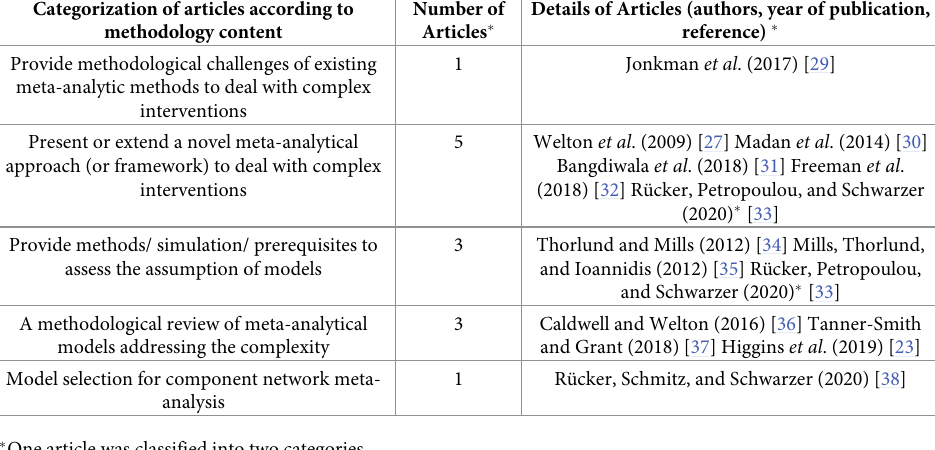
Table 1. Categorization of the twelve methodological articles with meta-analysis models that evaluate the effects of complex interventions. Categorization of articles according to Number of methodology content Articles � Provide methodological challenges of existing meta-analytic methods to deal with complex interventions Present or extend a novel meta-analytical approach (or framework) to deal with complex interventions Provide methods/ simulation/ prerequisites to Thorlund and Mills (2012) [34] Mills, Thorlund, assess the assumption of models and Ioannidis (2012) [35] Ru¨cker, Petropoulou, A methodological review of meta-analytical Caldwell and Welton (2016) [36] Tanner-Smith models addressing the complexity and Grant (2018) [37] Higgins et al . (2019) [23] Model selection for component network meta- 1 Ru¨cker, Schmitz, and Schwarzer (2020) analysis